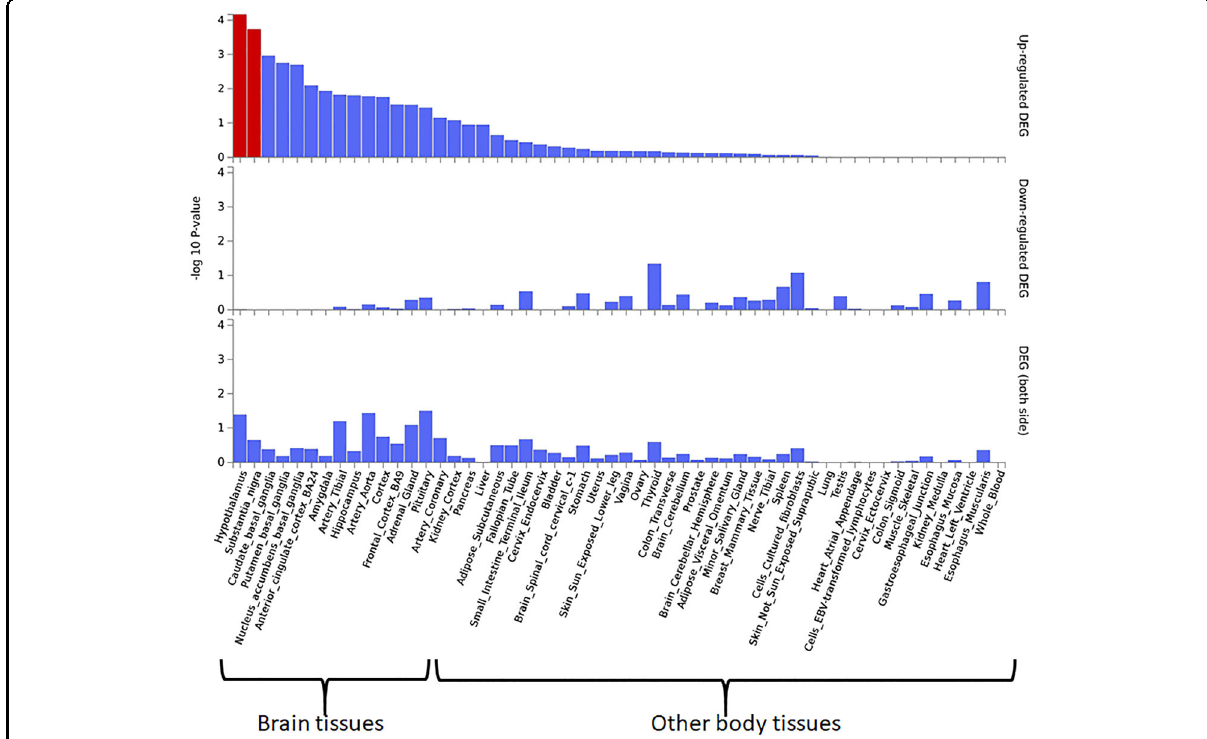
Fig. 7 Differently expressed gene (DEG) plots of 24 ADHD hot genes constructed with GTEX v8 across 54 tissue samples. Signi fi cantly enriched differently expressed gene sets, highlighted in red, belong to the hypothalamus and substantia